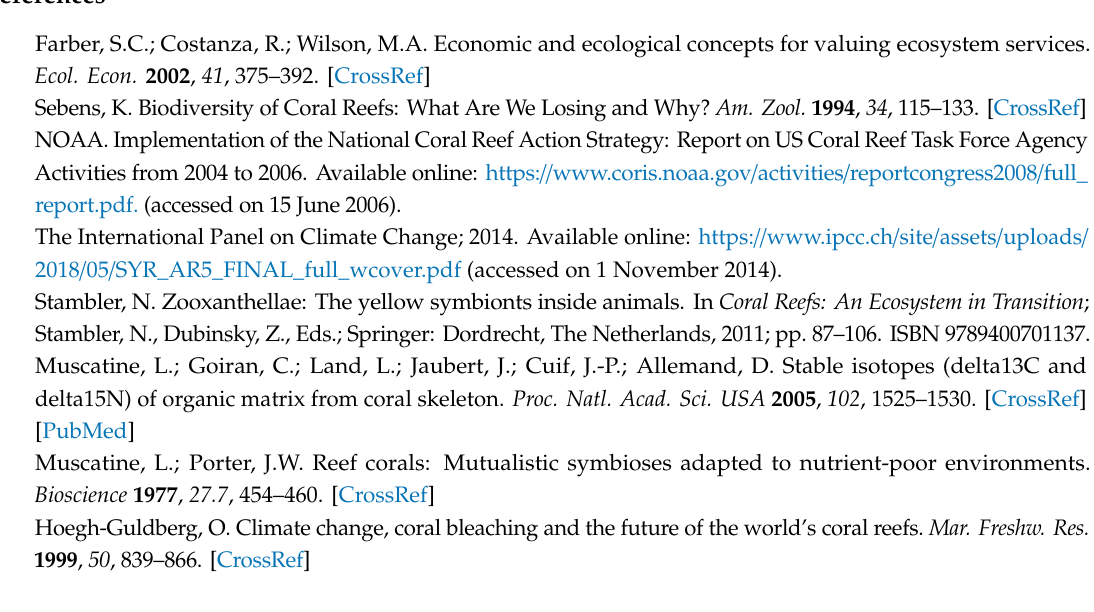
Figure S1: Hierarchical clustering dendrogram with p-values. Values on the edges of the clustering are p-values (%). Hierarchical clustering dendrogram with p-values was done using the R module pvclust (Suzuki & Shimodaira, 2006). Red values are AU (Approximately Unbiased) p-values, and green values are BP (Bootstrap Probability) values, Figure S2: Venn diagram of S; symbiotic polyps and AS, apo-symbiotic common genes. The diagram includes only the common genes from each treatment (340 common genes of apo-symbiotic and 632 common genes of control groups, see Figure 3). The numbers of up- (red arrows) and down- (green arrows) regulated genes are indicated within each field, as regard to the examined groups 28AS / 25S, 31AS / 25AS 28S / 25S, and 31S / 25S. Figure includes data of number of genes in common and unique groups, Table S1: Number of symbiont cells and chlorophyll measurements in representative fragments of each treatment, following one year in light / darkness conditions. Table S2: Summary of identified environmental stress genes in the treatments. Indicated in the table: the HS annotation, fold change of the four treatments (28 / 31: temperature of exposure in 0C, AS; apo-symbiotic polyps, S: symbiotic polyps, in yellow: treatments that follow the trend in the literature), annotated protein name, the trend in the literature (up / down-regulated), correlation (purple; the treatments’ fold change is in correlation to the morph, green; the treatments fold change is in correlation to the temperature treatment), and which morph corresponds with the trend in the literature, Table S3: Summary of identified symbiosis genes in the treatments. Indicated in the table: reference, annotated protein name in the reference, process in the cell, HS annotation, fold change of the four treatments (28 / 31: temperature of exposure in 0C, AS: apo-symbiotic polyps, S: symbiotic polyps), annotated protein name, the trend in the reference (up / down-regulated / unique in S: symbiotic / AS: apo-symbiotic cnidaria, yellow: our results are in the same trend as in the paper, orange; our results are partially in the same trend as in the paper), and correlation (purple: the treatments’ fold change is in correlation to the morph, green; the treatments fold change is in correlation to the temperature